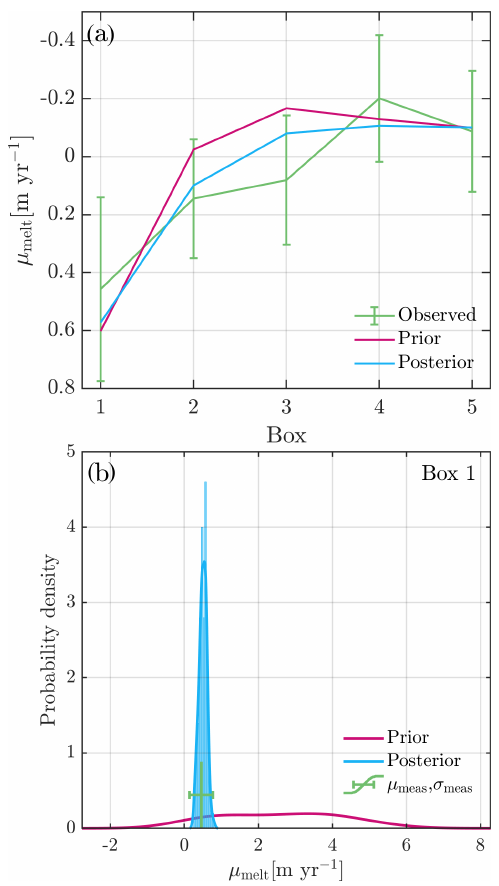
Figure B2. (a) Observed and modelled mean melt rates ( µ melt ) for each box in box model melt parameterization. Observations and standard deviations from Moholdt et al. (2014) are shown in green. Pink and blue lines use sample point estimates from Table B1 to compare prior and posterior box melt rates. Prior melt rates (pink) use the same parameters for γ ∗ and c from Reese et al. (2018a) and T use mean sample point estimates from our priors for τ and α . The posterior melt rates (blue) use sample point estimates from all pa- rameters from our final posterior distributions. (b) shows the prob- ability distributions of melt rates in Box 1 (closest to the grounding line) using the entire sample set for both priors and posterior. Note the tight distribution around observations (green) for the posterior